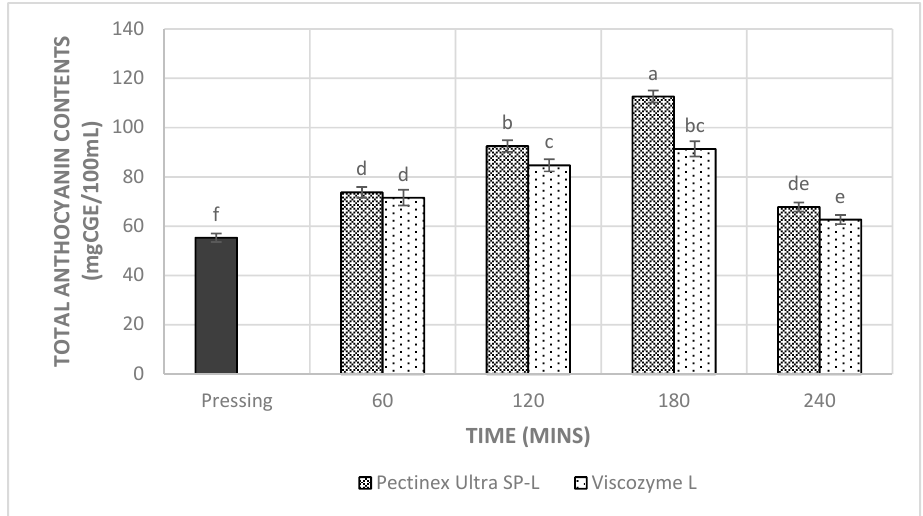
Figure 6. The effects of enzyme treatments on the total anthocyanin content of mulberry juice. The values are mean ± SD ( n = 3). Means sharing different letters are significantly different ( p < 0.05).